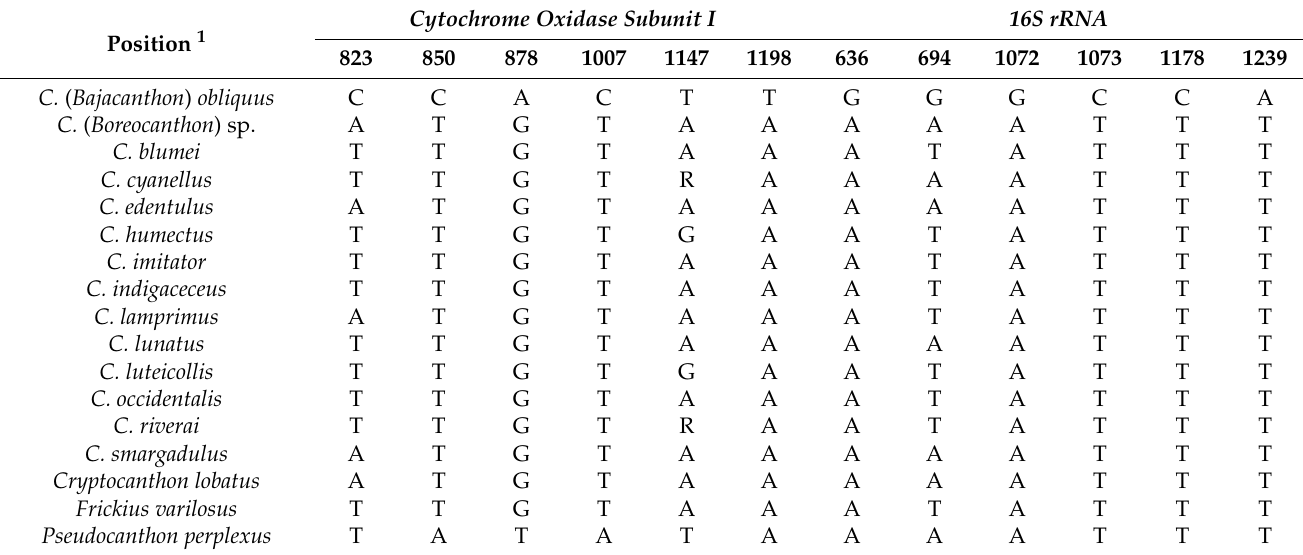
Table 1. Fixed segregated sites for Canthon ( Bajacanthon ) obliquus .